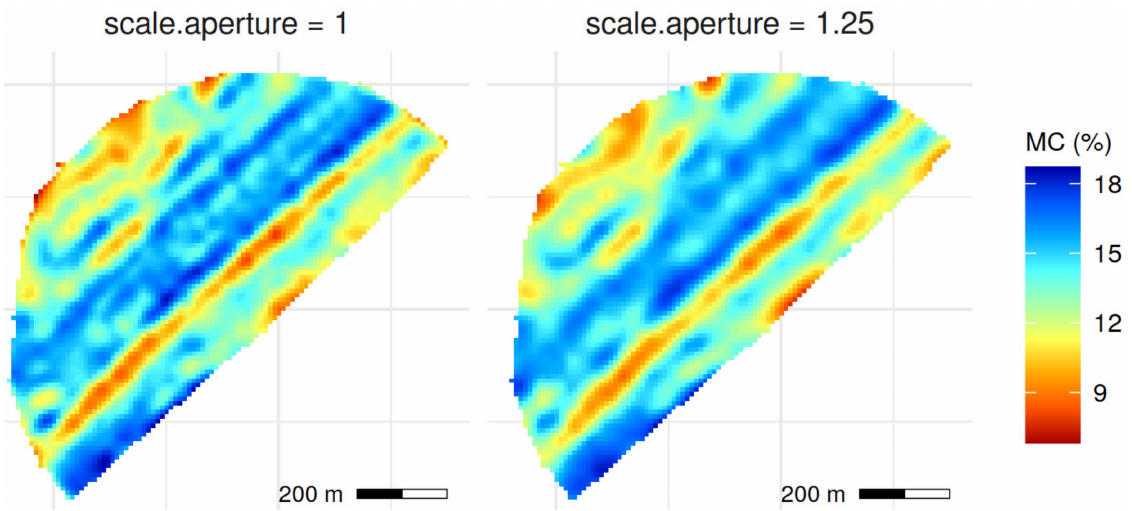
Figure 9. FRK interpolation results (moisture content %) for two different bisquare function distribu- tion